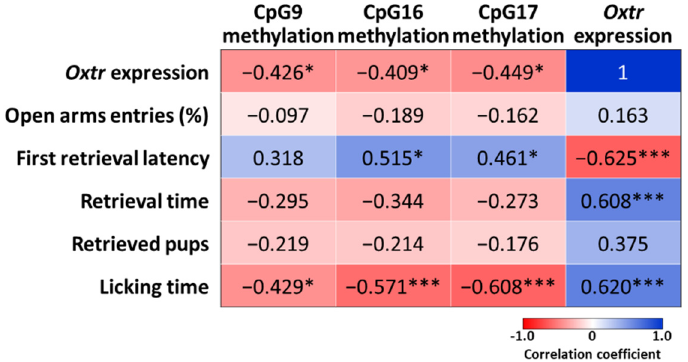
Figure 4. Correlations between Oxtr methylation, Oxtr expression, and maternal behaviors. Pearson’s correlation was used to assess the relationships between Oxtr methylation, Oxtr mRNA, and maternal behaviors. Data are presented in the correlation coefficient. *: p < 0.05; ***: p < 0.005.